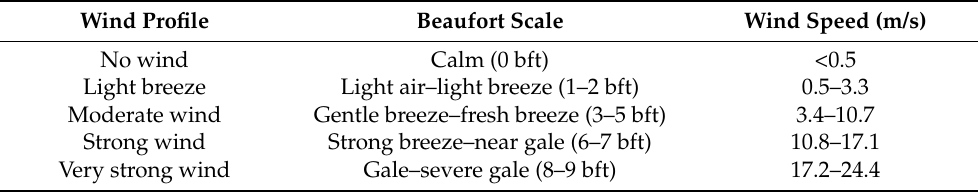
Table 2. Wind profiles of the current study associated with corresponding Beaufort scale